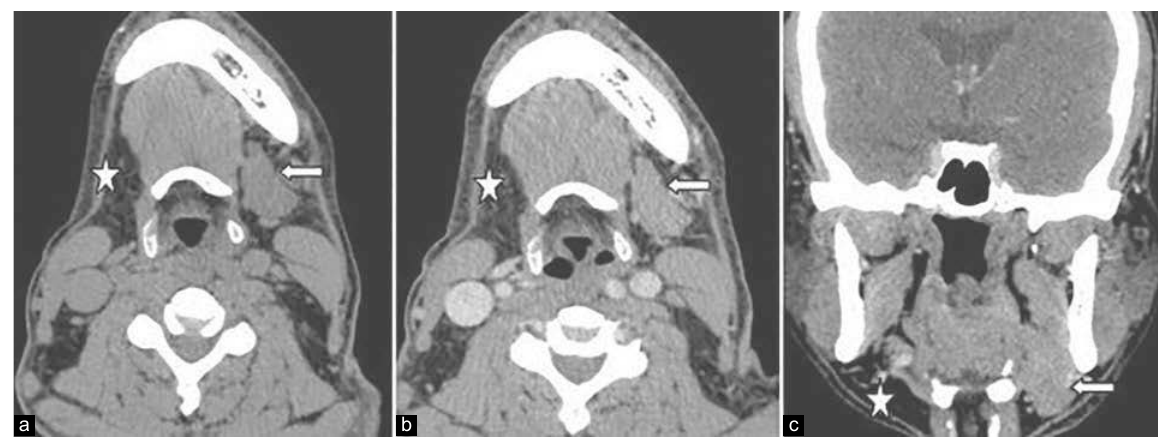
a b c (a–c) Axial plain and contrast-enhanced computed tomographic images of the neck in venous phase with reformatted coronal images show absent right submandibular gland (star) with compensatory hypertrophy of the contralateral left submandibular gland (left arrow).